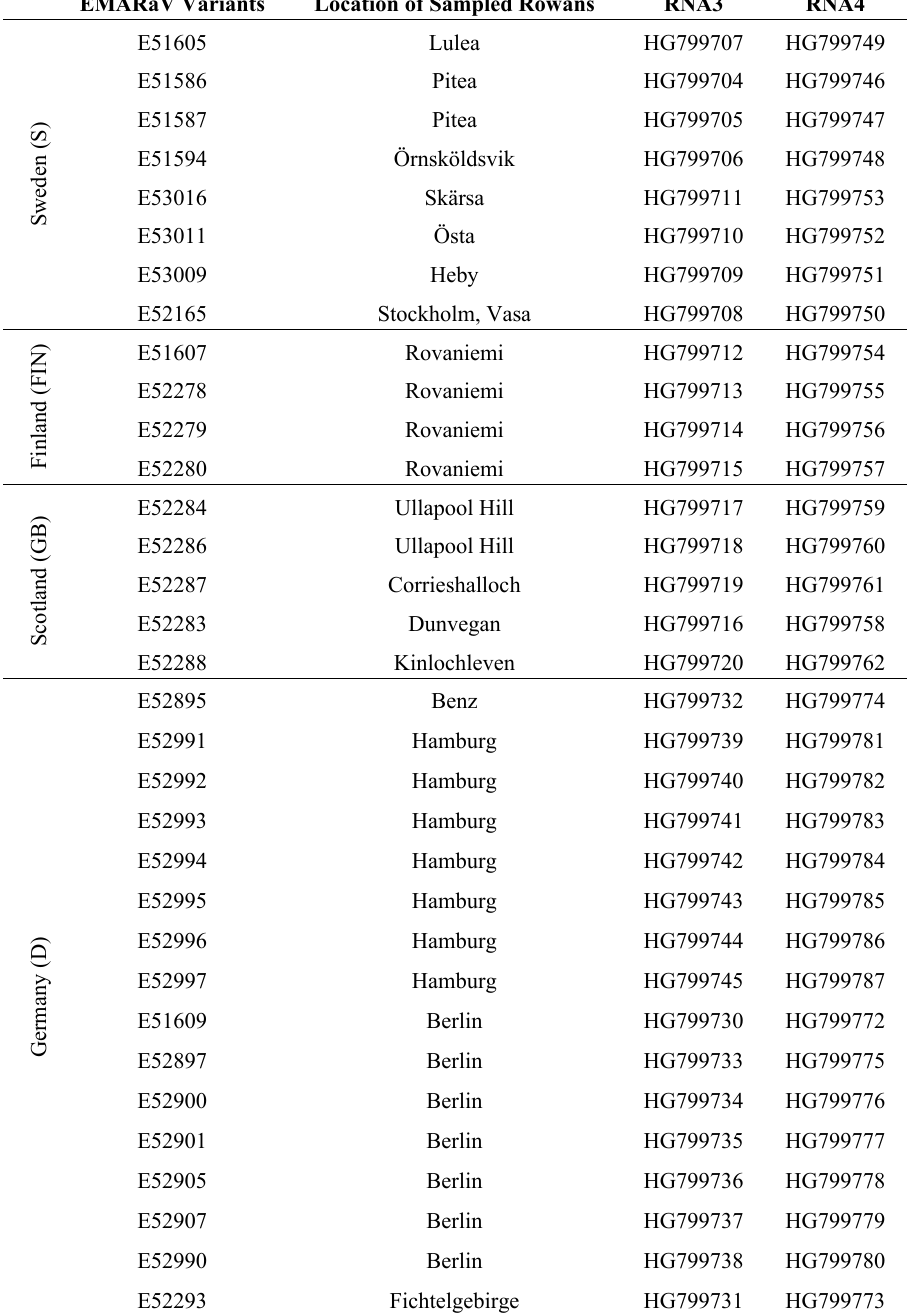
Table 1. Forty-two European mountain ash ringspot-associated virus (EMARaV) variants and the related accession numbers are listed according to the geographic origin of the sampled S. aucuparia